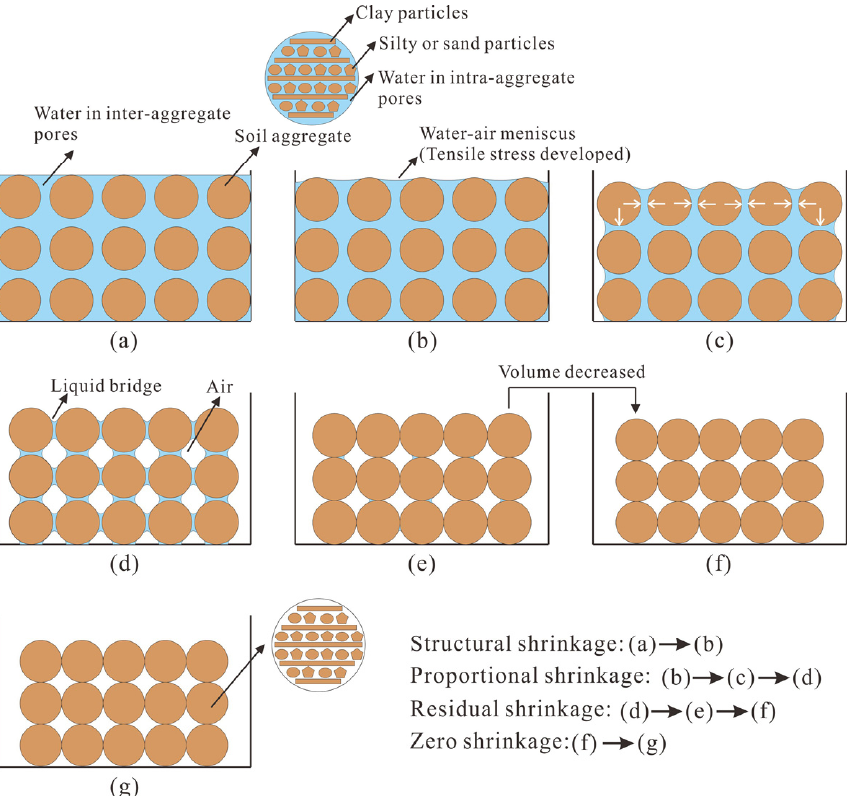
Figure 7. Schematic drawings of simplified soil shrinkage process. ( a – g ) present different states of soil sample during structural, proportional, residual and zero shrinkage.